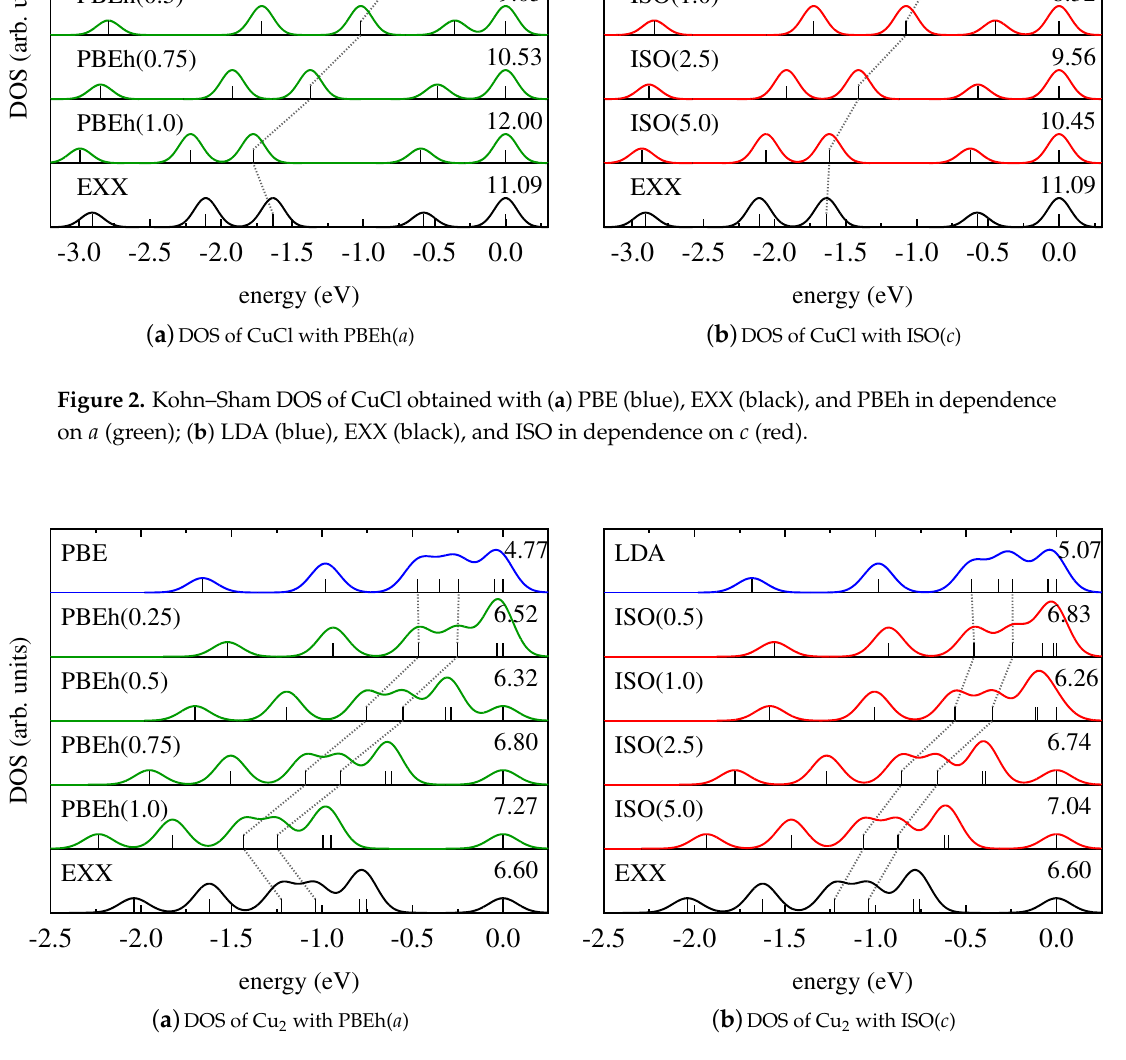
Figure 3. Kohn–Sham DOS of Cu 2 obtained with ( a ) PBE (blue), EXX (black), and PBEh in dependence on a (green); ( b ) LDA (blue), EXX (black), and ISO in dependence on c